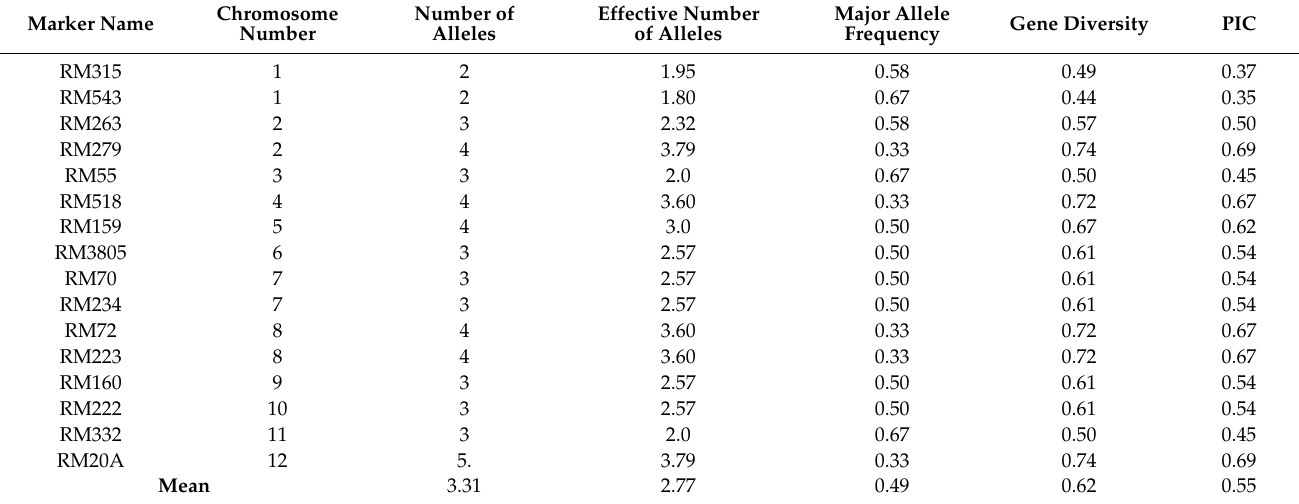
Table 6. Genetic details of the sixteen polymorphic SSR markers used in this